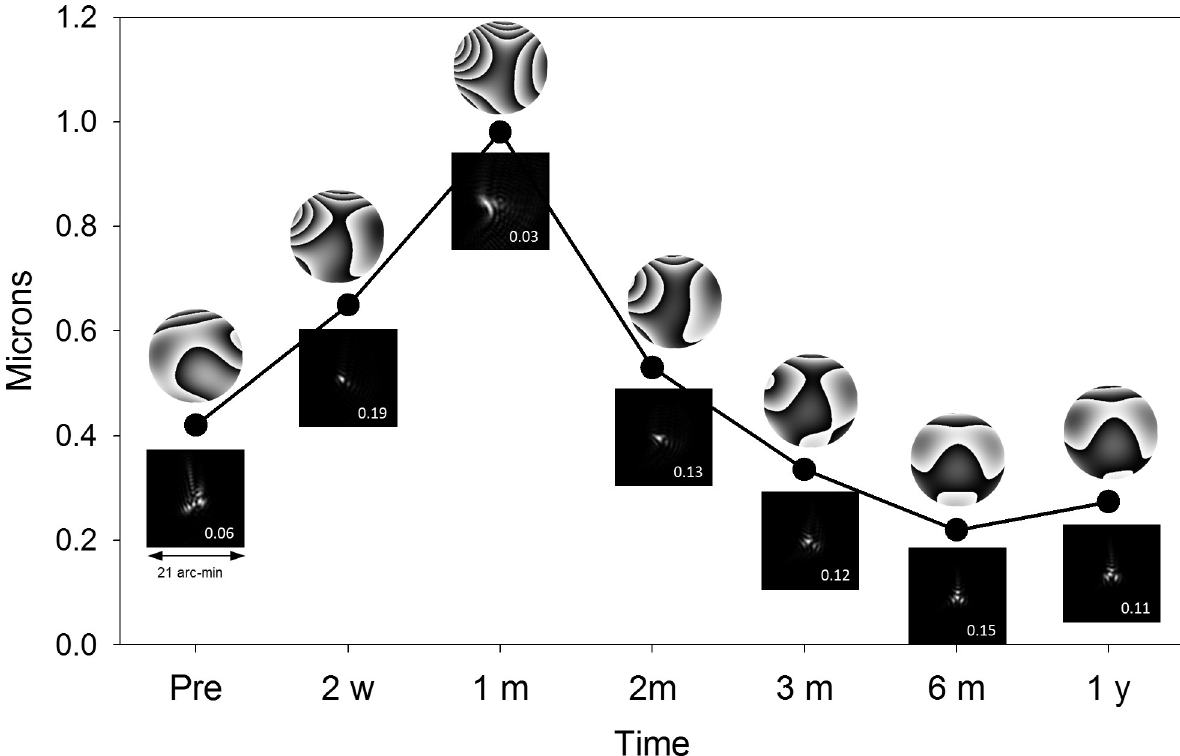
Fig 6. RMS as function of time and corresponding modulus 2 π representations of the WA and the associated PSFs with the Strehl ratio values considering astigmatism and HOA (defocus Zernike coefficient 4 set to zero) in the right eye of patient S1. 4-mm pupil diameter.